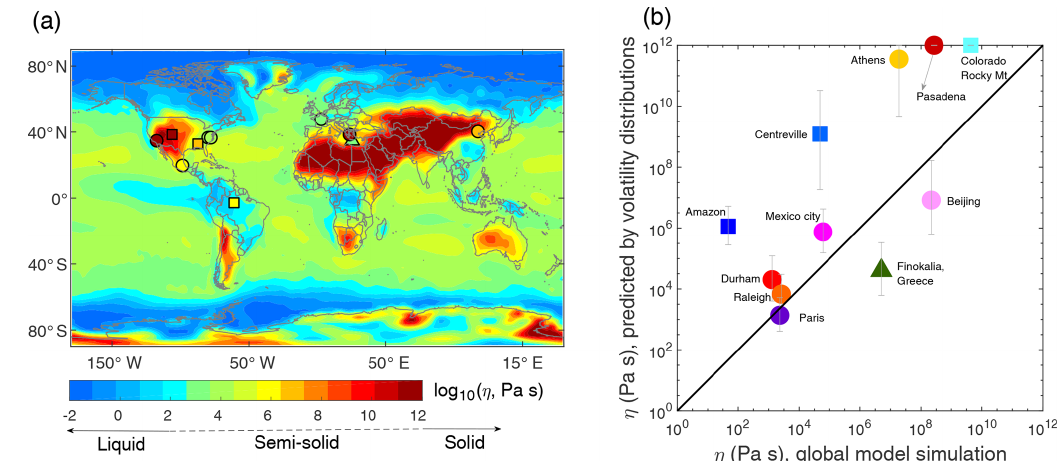
Figure 6. (a) Global distributions of SOA annually averaged viscosity at the surface simulated by a global chemical transport model (Shi- raiwa et al., 2017) with the viscosity predicted by measured volatility distributions at 11 global sites (triangle, square, and circle represent remote, forested, and urban sites, respectively, Table S3). The color code indicates viscosity on a log scale. (b) Predicted viscosity based on measured volatility distributions compared against the viscosity in global simulations. The error bars correspond to uncertainties in viscosities calculated from uncertainties in predicted T g , org shown in Fig.